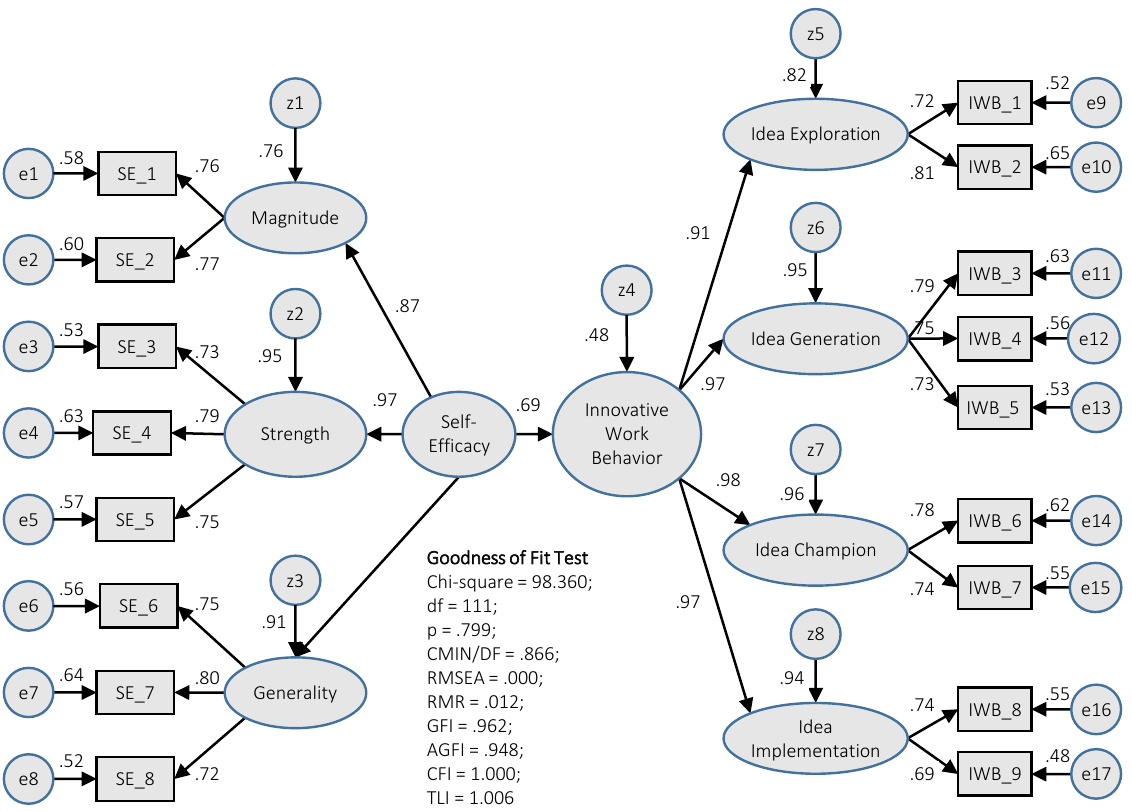
Figure 1. Multidimensionality of structural equation